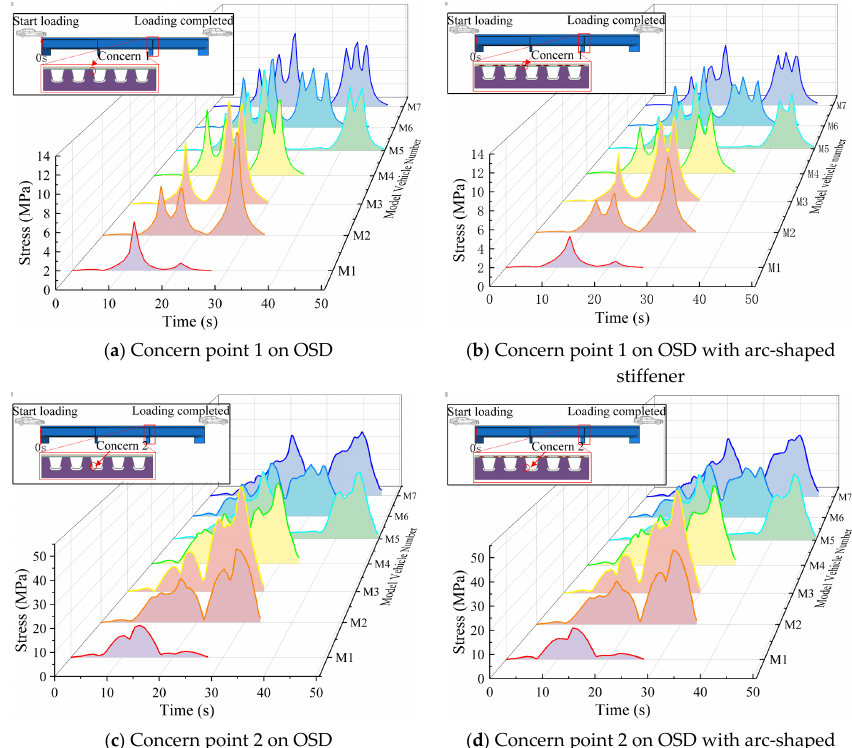
Figure 10. Dynamic response of OSD with/without stiffener.